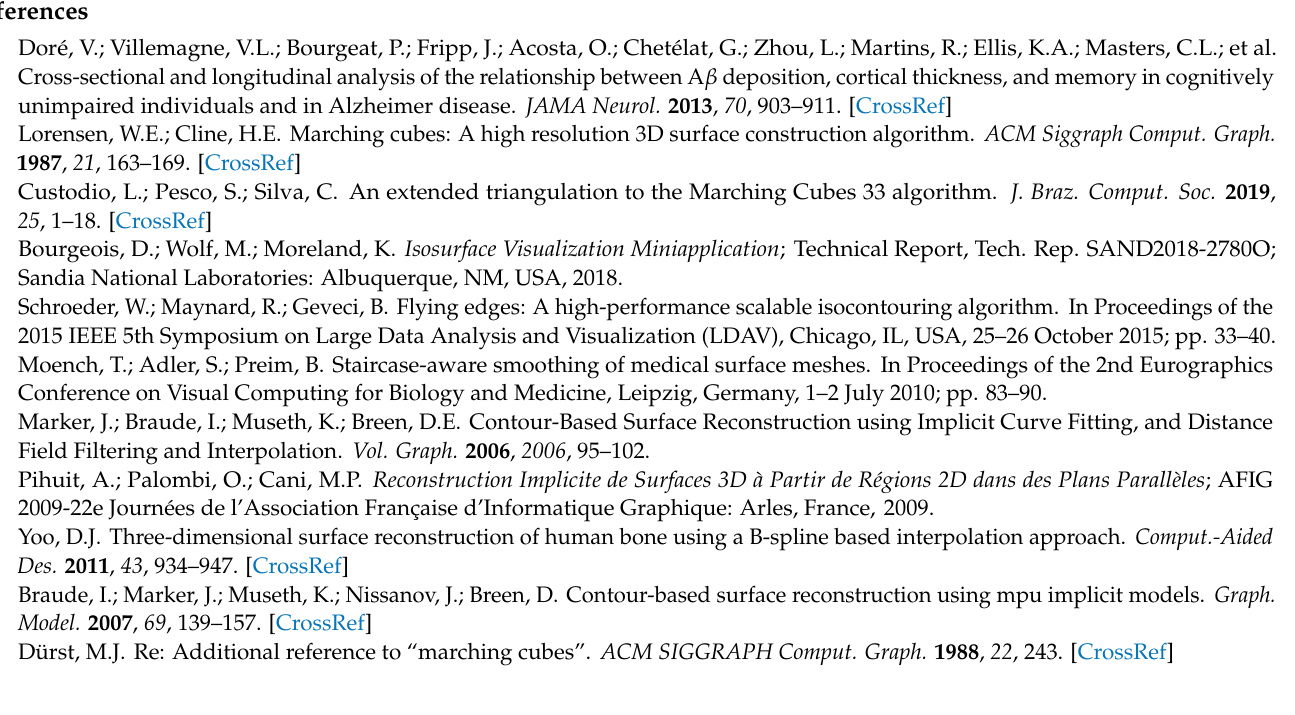
Figure A1. Reconstruction of the Brain, Ventricle, and Skull-Bone with FE (yellow), MPU (red), and Hybrid (green). From left to right: overlaid models followed by a zoom on the highlighted areas showing the reconstruction result of each